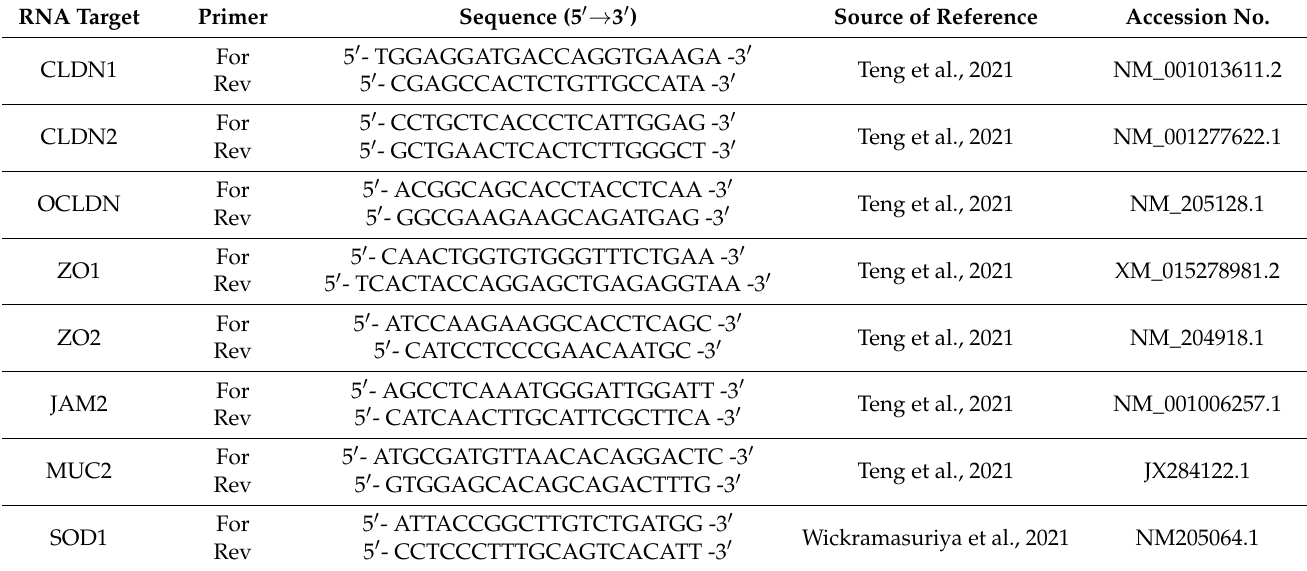
Table 6. Primers used for quantification of mRNA expression of tight junction proteins, mucin, and antioxidant genes by